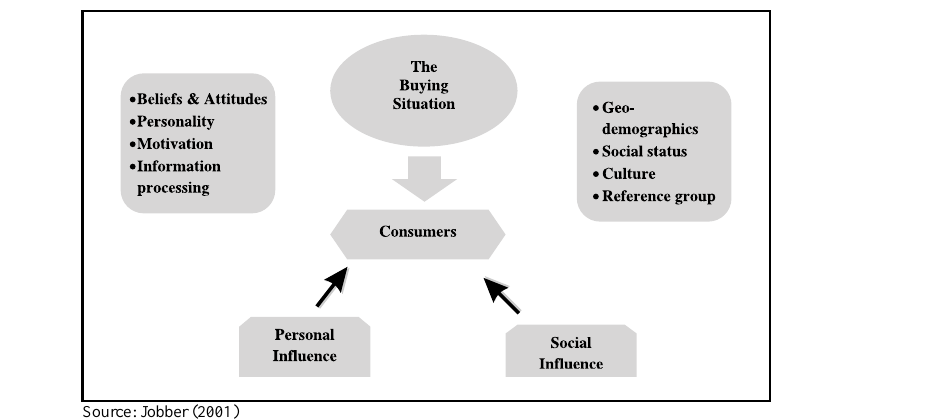
Figure 1: Influences on Consumer Buying